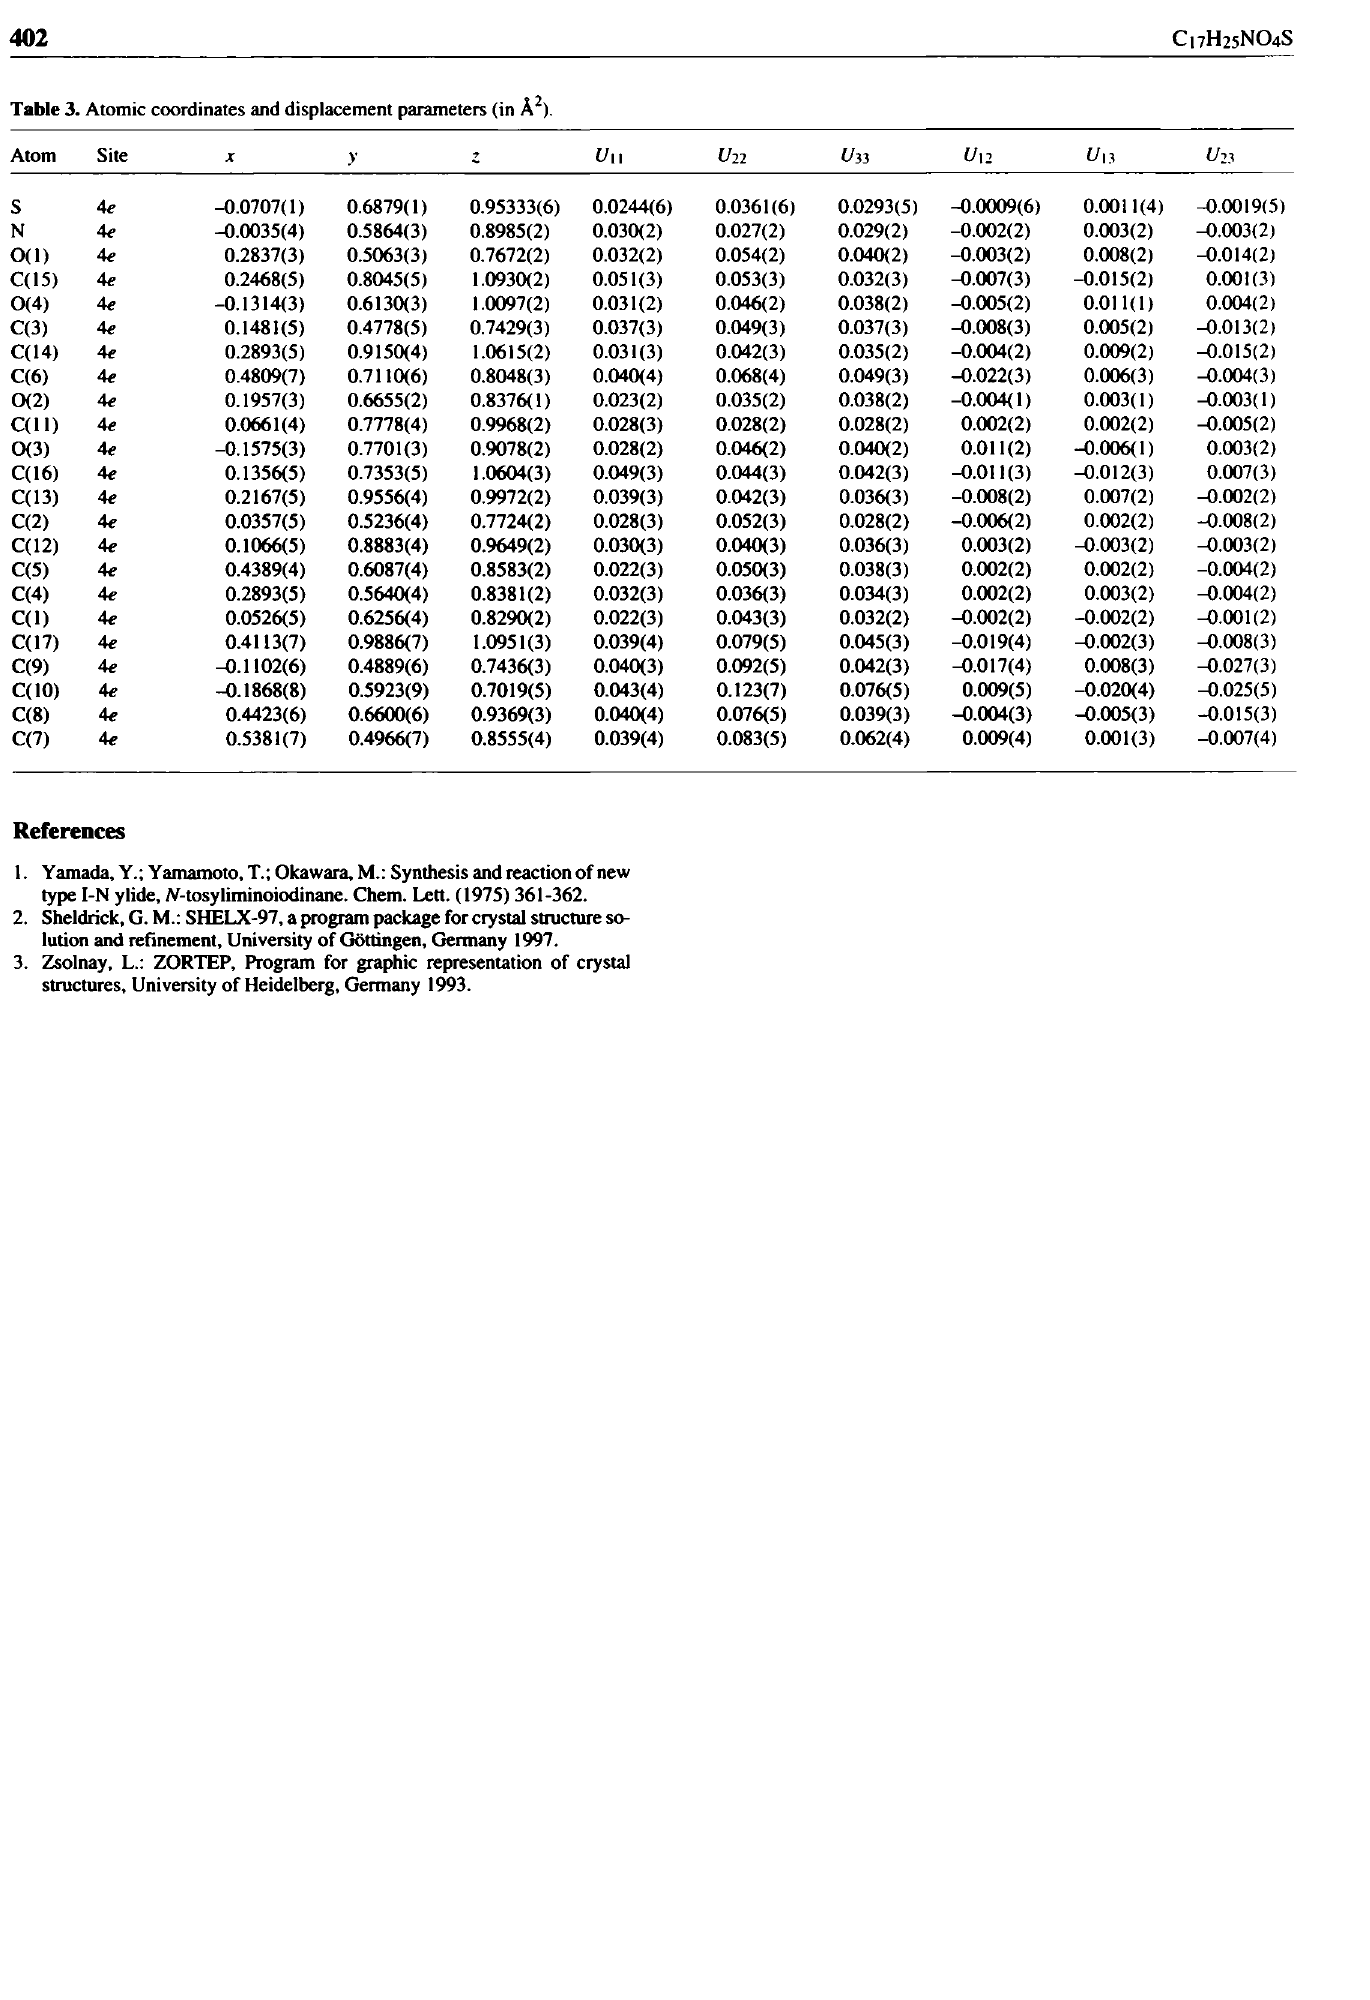
Table 3. Atomic coordinates and displacement parameters (in Ä 2